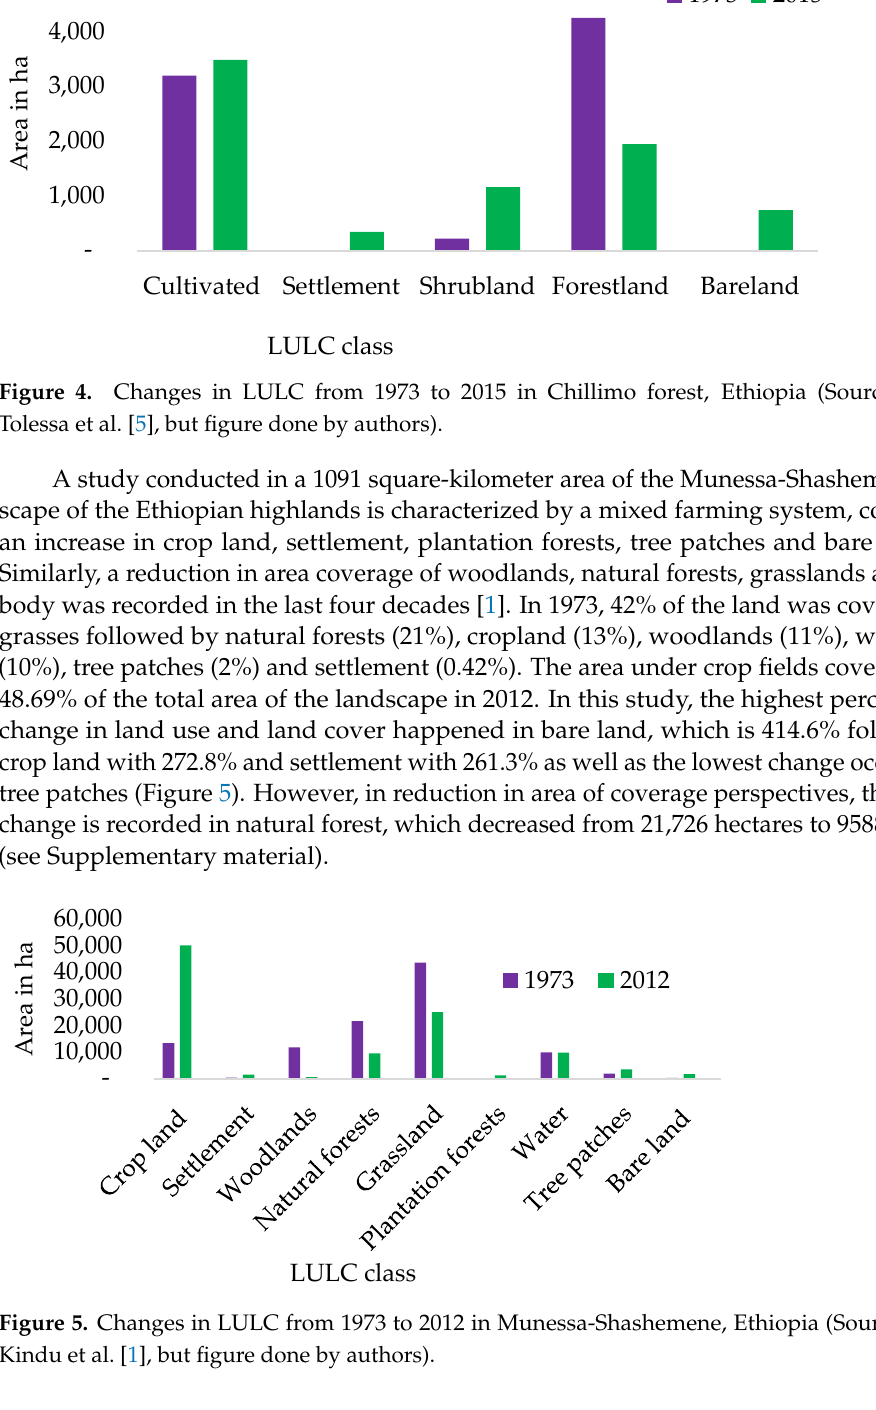
Figure 6. Changes in LULC from 1973 to 2014 in Toke Kutaye, Ethiopia (Source of data: Tolessa et al. [56], but figure done by authors).